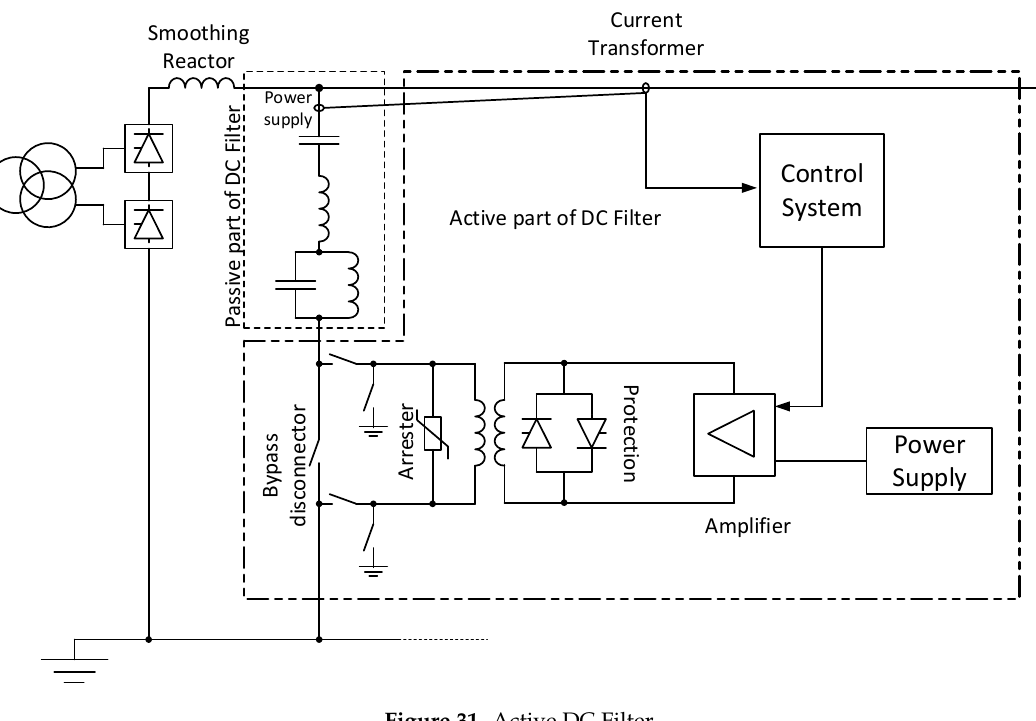
Figure 31. Active DC Filter.